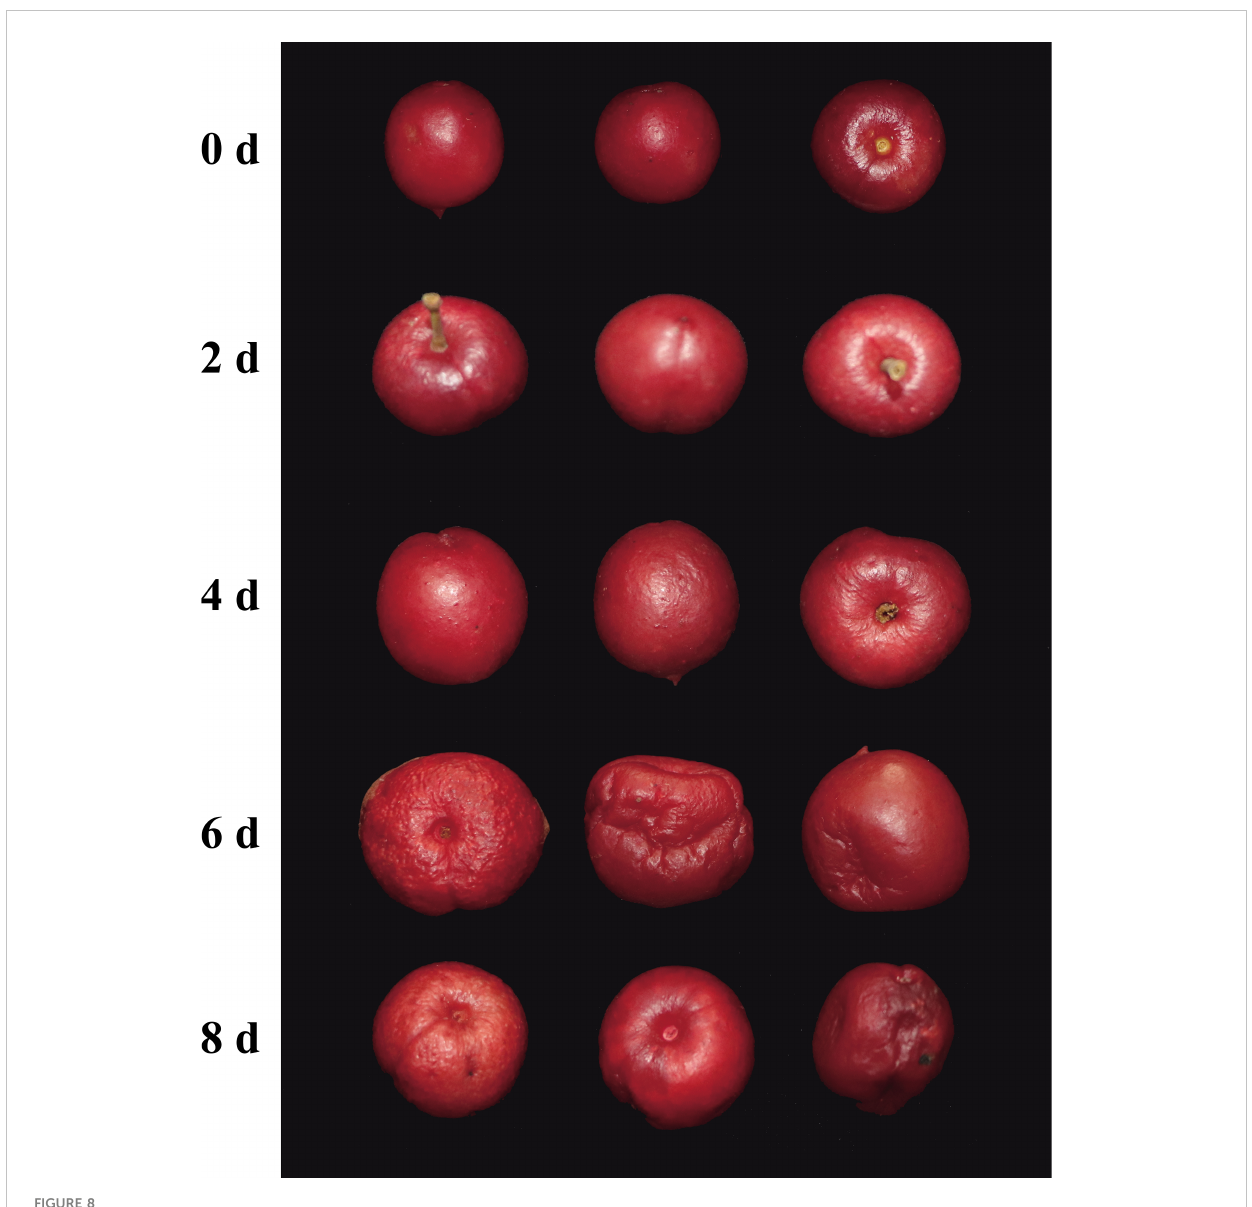
FIGURE 8 Fruit surface changes with low temperature storage time of C.